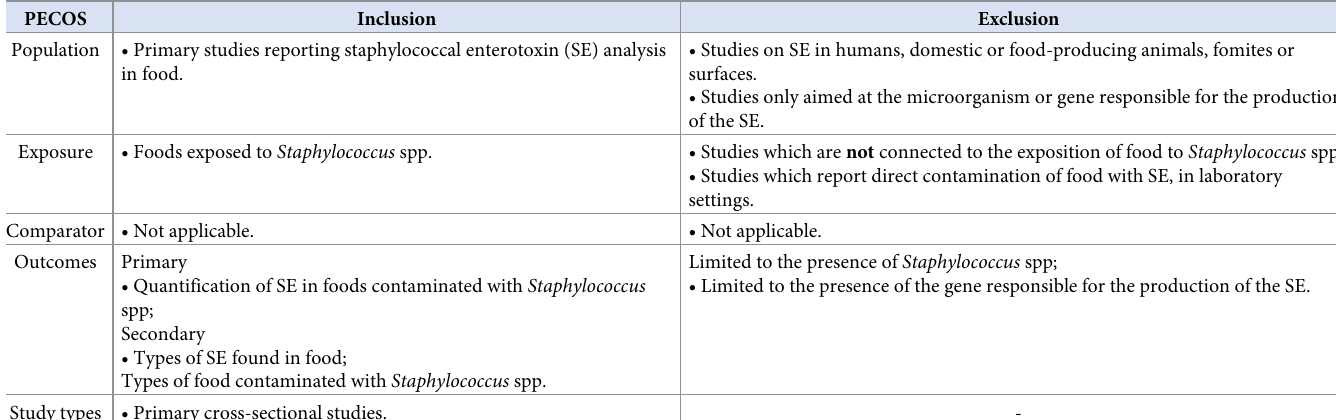
Table 1. Eligibility criteria based on PECOS (Population, Exposure, Comparator, Outcomes and Study Types). PECOS